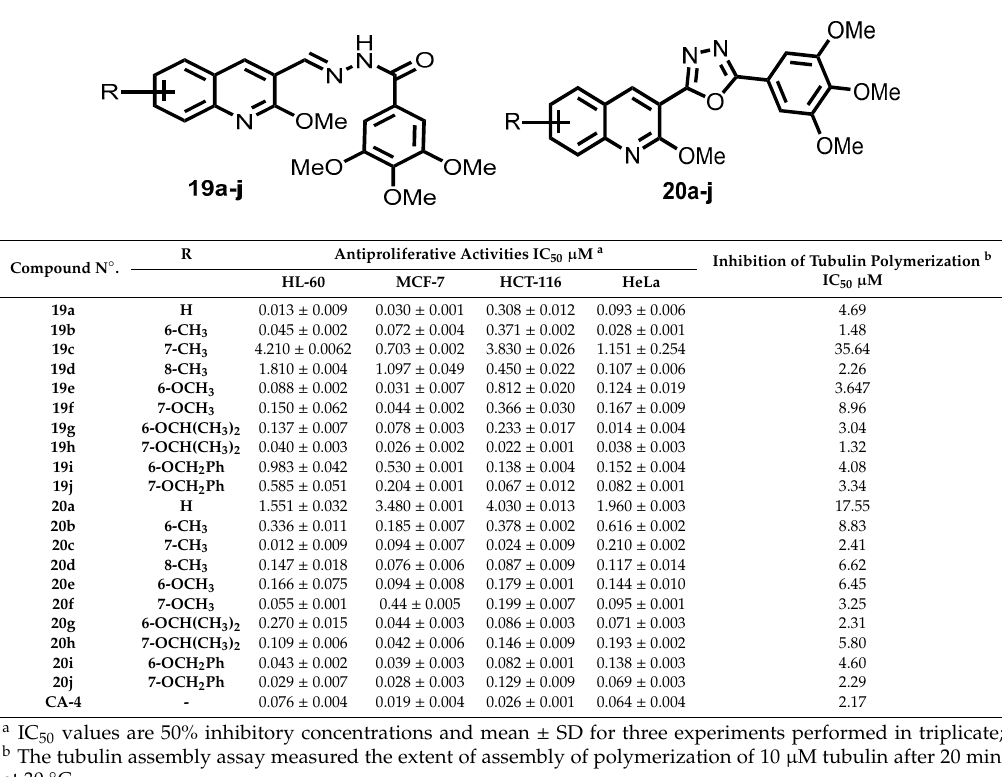
Table 1. Antiproliferative activity of quinolines 19a – j and 20a – j against human cancer cell lines.